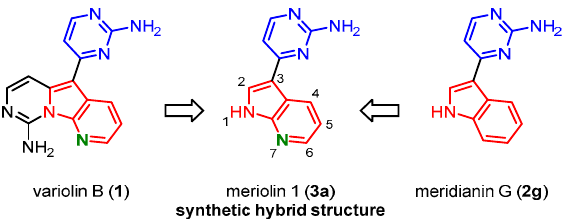
Figure 3. Meriolin 1 ( 3a ) as a synthetic hybrid structure of variolin B ( 1 ) and meridianins 2 [14]. Meriolin 1 ( 3a ) has first been synthesized by Fresneda und Molina [15], while the name meriolin was shaped by Meijer and co-workers [14,16,17]. The 2-aminopyrimidine- substituted 7-azaindoles exhibit pronounced cytotoxicity against several selected cancer cell lines with IC 50 values in the nanomolar range [18–20] and initiate cell death hallmarks such as cell cycle arrest and decrease in the mitochondrial membrane potential, ΔΨ m.